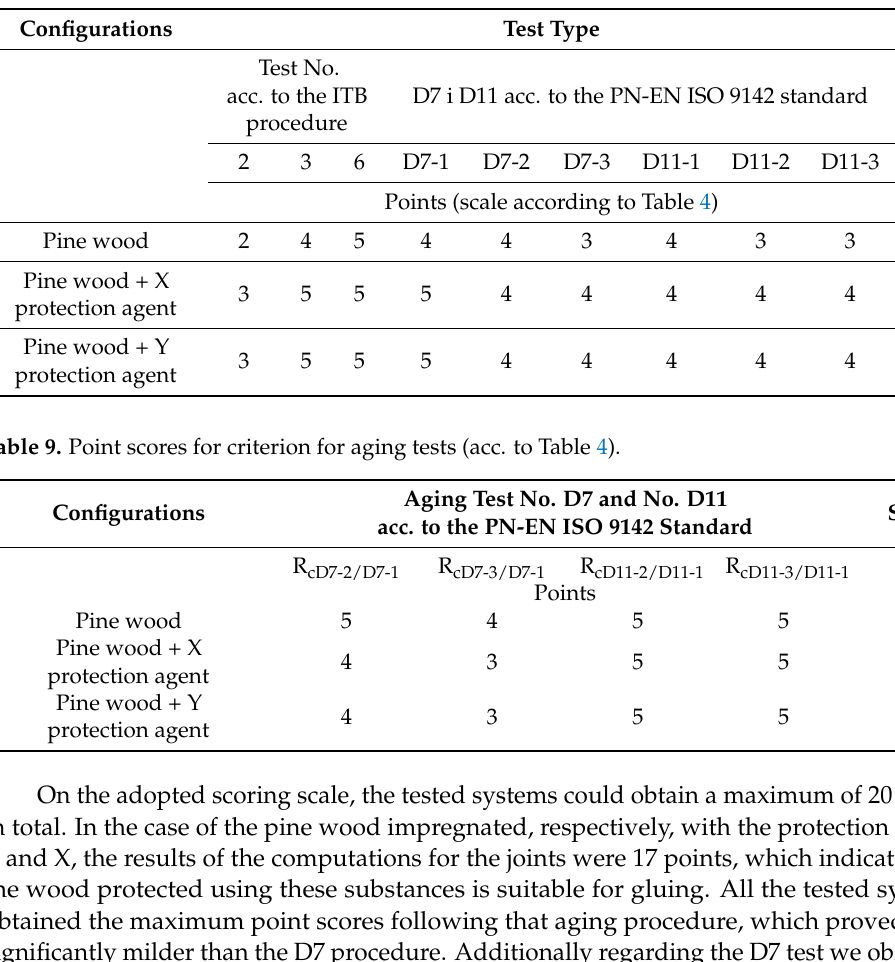
Table 8. Point scores for adhesive joints after individual tests (acc. to the criterion in Table 3).